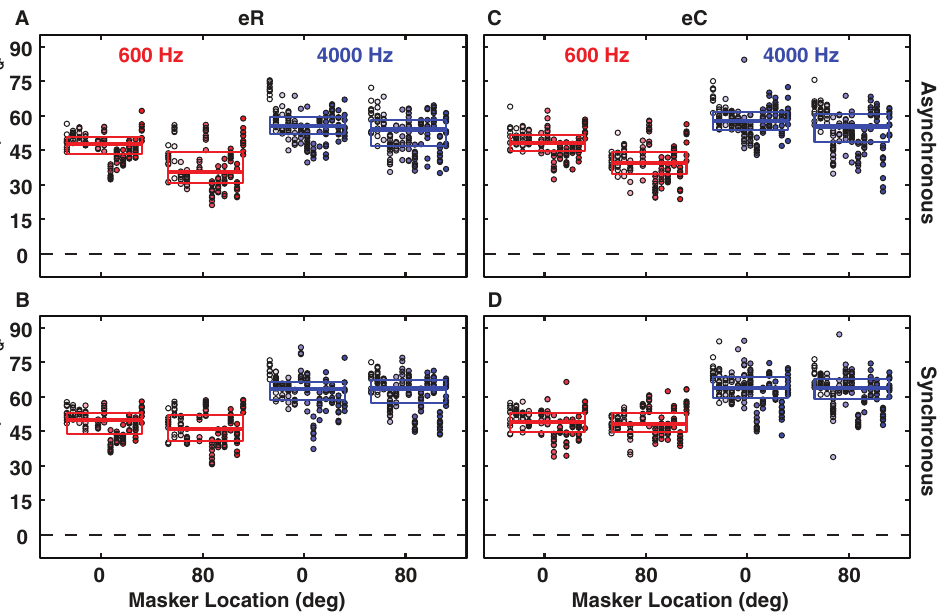
Figure 2. Signal detection thresholds re T Q in the presence of random frequency (eR: A, B) and constant frequency (eC: C, D) energetic maskers as a function of masker location for the the 600-Hz (red) and the 4000-Hz (blue) signals in the asynchronous (A, C) and synchronous (B, D) timing conditions. All other conventions as in Fig. 1.